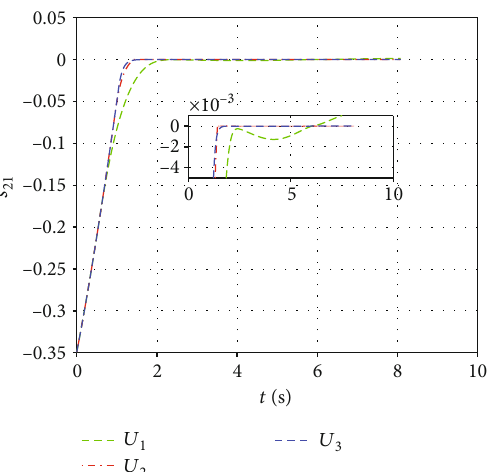
Figure 24: Dynamic error surfaces s